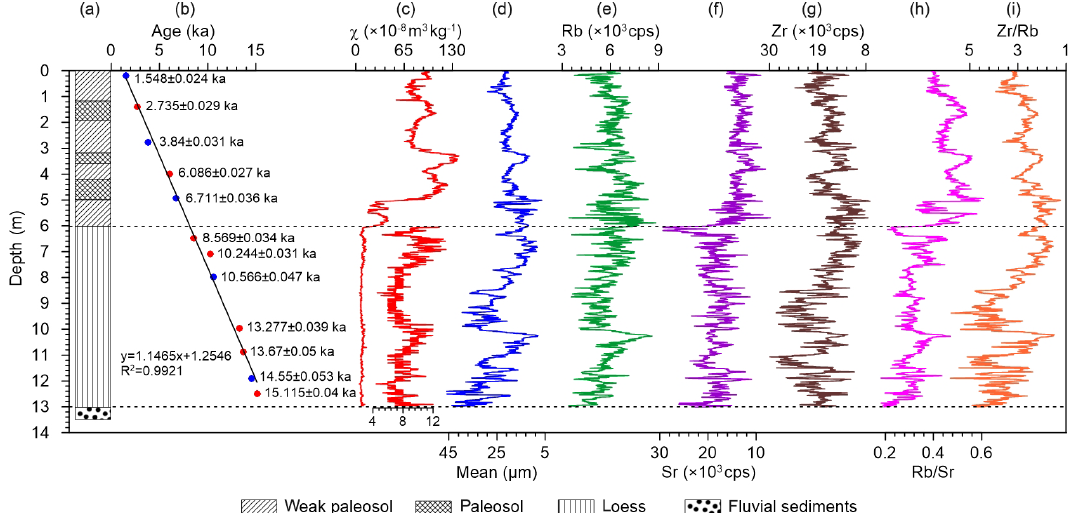
Figure 2. (a) Stratigraphy, (b) age–depth model, (c) magnetic susceptibility, (d) grain-size results and (e–i) elemental results measured by scanning XRF of the DDW core. Five red dots are ages in previous work (Liu et al., 2018). Blue dots are seven additional ages in this study. The elemental results were smoothed with a three-point moving